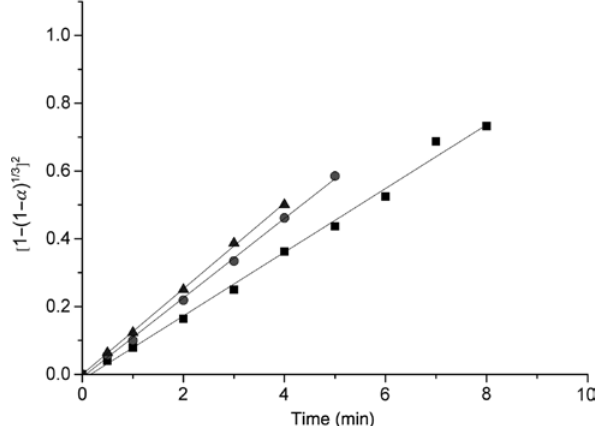
Figure 7: The isothermal dependences of [1– (1 – α ) 1/3 ] 2 versus time at 40 ° C ( ), 55 ° C ( ) and 60 ° C ( ).